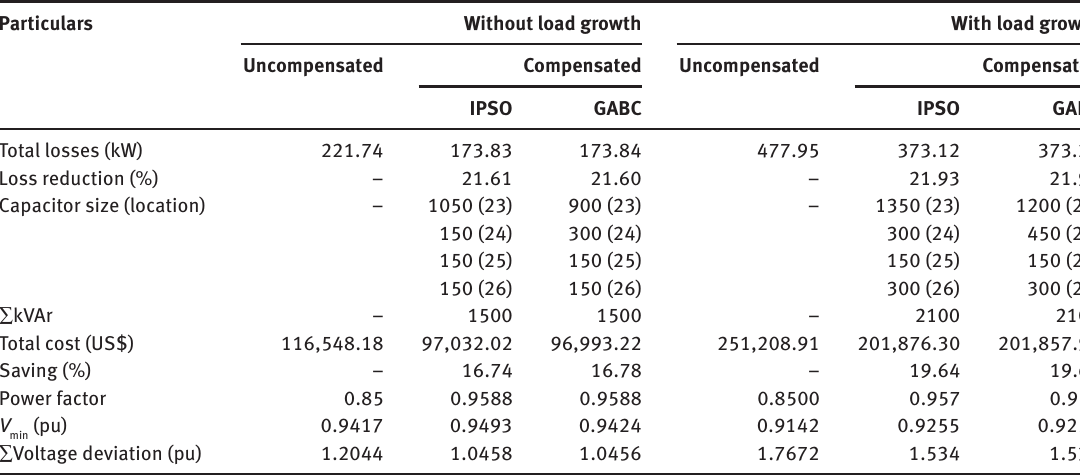
Table 4: Simulation Results of the 34-Bus Distribution Network after SC Placement Using the IVM